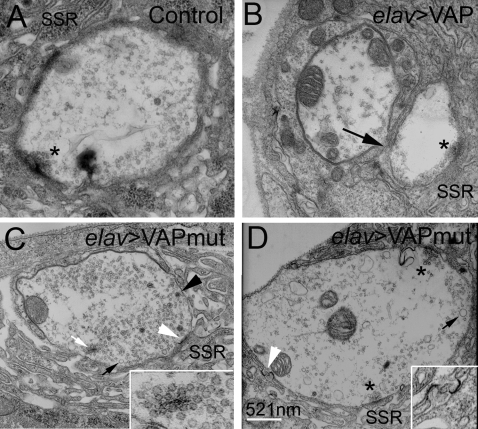
Ultrastructural analysis of the neuromuscular junction of animals overexpressing VAPwt and VAPP58S.(A–D) Electron micrographs depicting cross sections of synaptic boutons in control (A), elav-GAL4/UAS-VAPwt (B), and elav-GAL4/UAS-VAPP58S larvae (C and D). Specialized membrane folds present on the postsynaptic surface called the subsynaptic reticulum (SSR), and active zones (asterisks) that include presynaptic T-bars are indicated. As compared to control boutons (A), boutons from animals overexpressing wild type VAP are smaller and contain fewer neurotransmitter vesicles (B). Occasionally, fusion of adjacent boutons was observed (arrow). (C and D) Boutons from elav-GAL4/VAPP58S animals are shown. In addition to the smaller neurotransmitter containing vesicles, a few large vesicles were observed (C, dark arrow). Electron dense T-body-like structures associated with clusters of vesicles are often observed within the cytoplasm of the bouton (C, white arrow and inset). Abnormal electron dense structures are also found in the SSR close to the post-synaptic membrane (C and D, white arrowhead; inset in D).